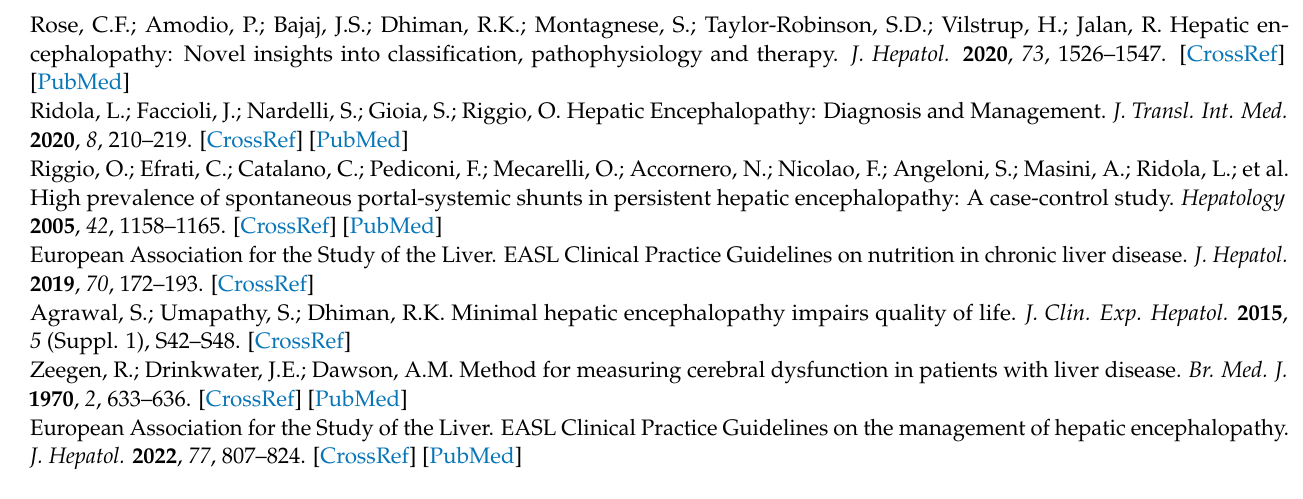
MHE; Supplementary Table S2: published studies on treatment of minimal hepatic